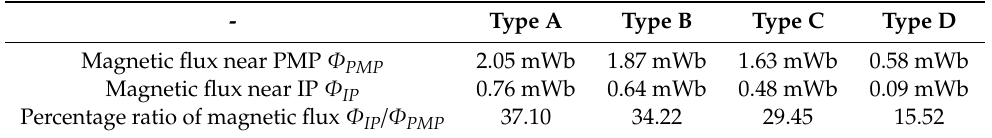
Table 2. Air gap magnetic flux density distribution for different types of PMs.